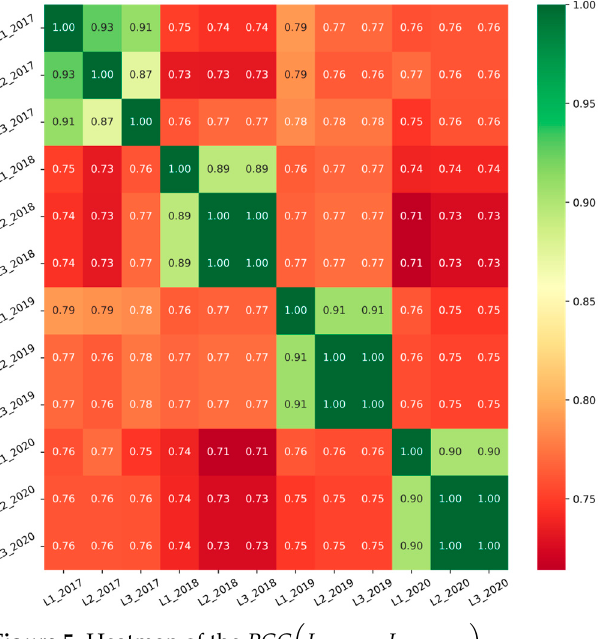
Figure 5. Heatmap of the 𝑃𝐶𝐶(cid:3435)𝐿 ((cid:3036),(cid:3052)(cid:3032)(cid:3028)(cid:3045)) , 𝐿 ((cid:3036) (cid:4594) ,(cid:3052)(cid:3032)(cid:3028)(cid:3045) (cid:4594) ) (cid:3439) .